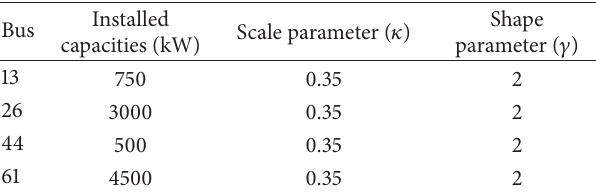
Table 1: Installed capacities of PV arrays and parameters of the Weibull